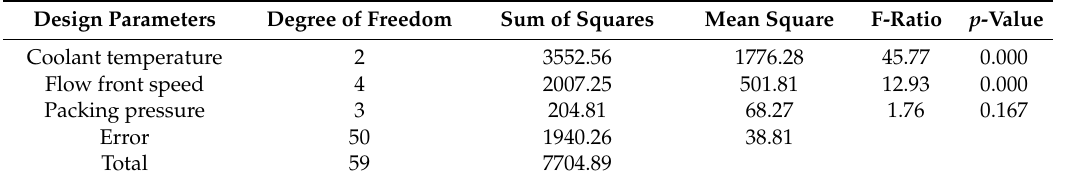
Figure 13. E ff ect of the molding conditions on the surface gloss. Figure 13. Effect of the molding conditions on the surface gloss. Figure 13. Effect of the molding conditions on the surface gloss. Table 3. Analysis of variance (ANOVA) for specular Table 3. Analysis of variance (ANOVA) for specular gloss. Table 3. Analysis of variance (ANOVA) for specular gloss.